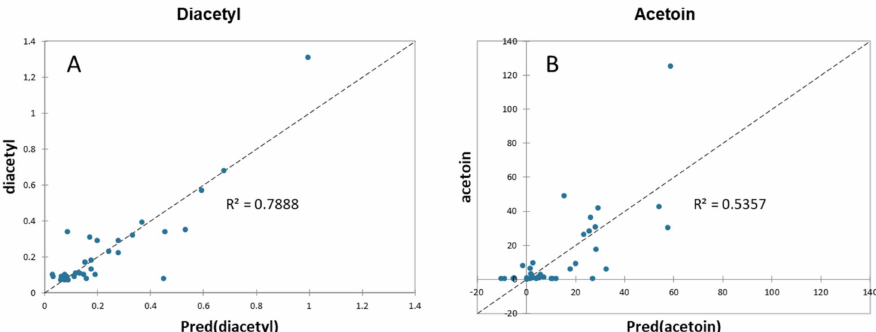
Figure 5. Correlation plots between the actual and predicted values of ( A ) diacetyl and ( B ) acetoin with a polynomial function of the second